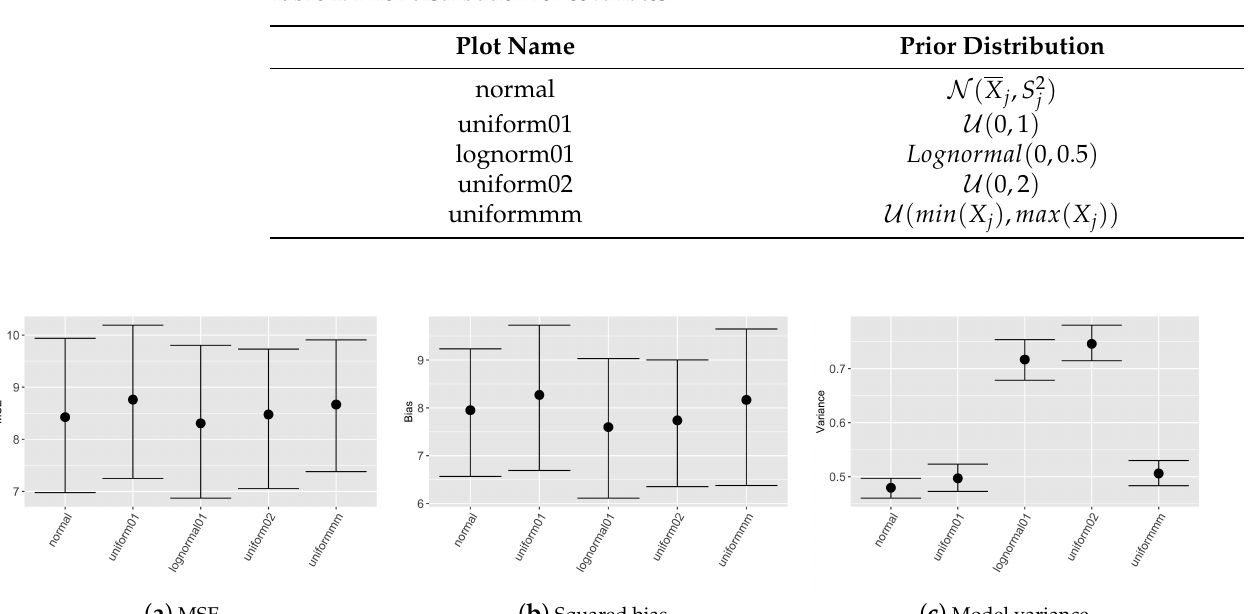
Table 1. Prior distribution for covariates.